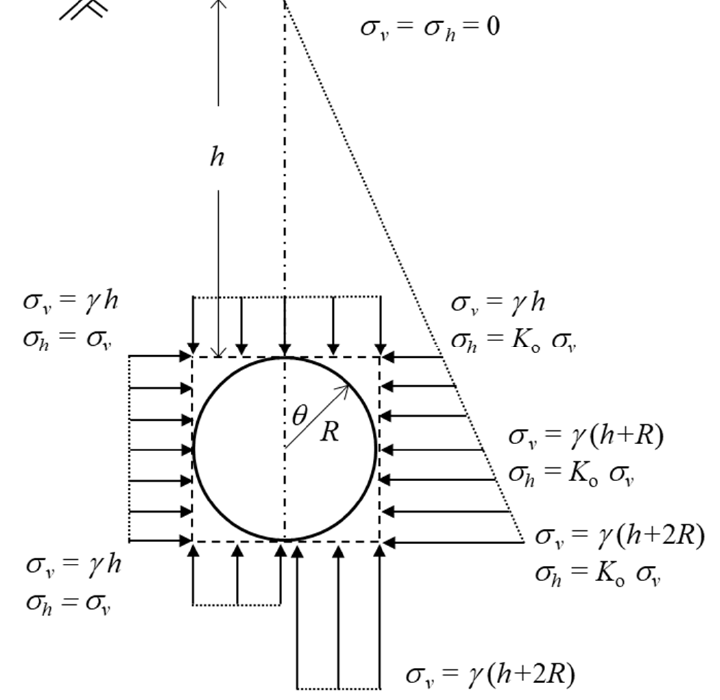
Figure 1. Schematic diagram of overburden pressure for initial isotropic/anisotropic stress around a circular tunnel.